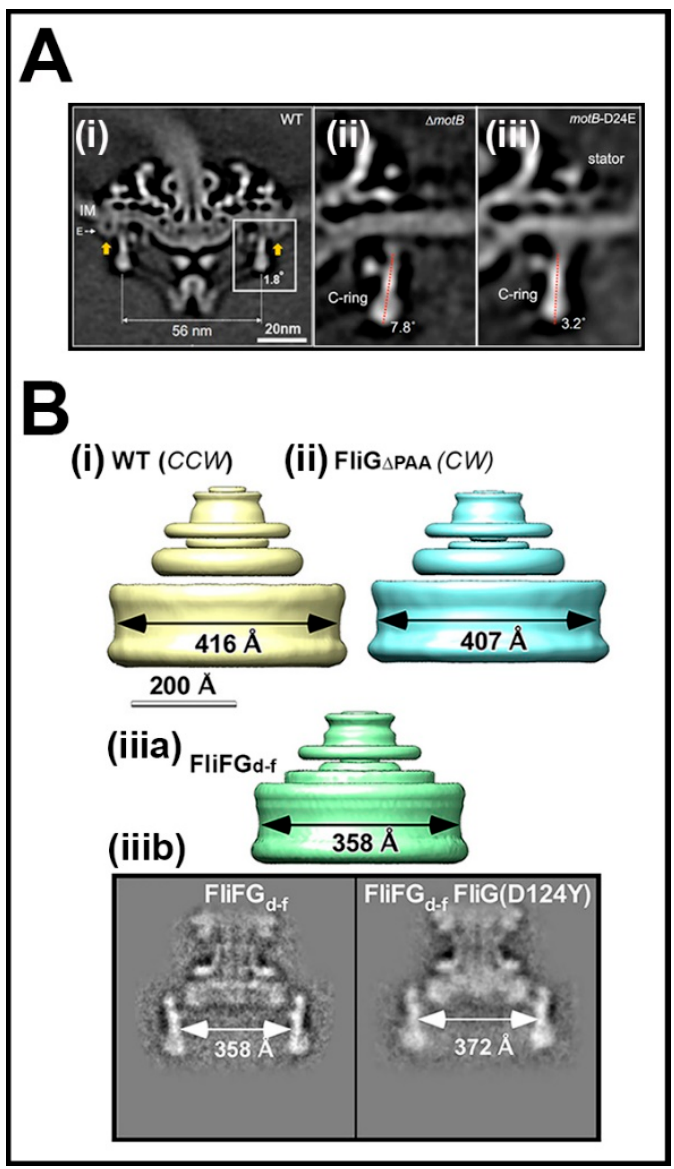
Figure 6. C ring modulation by interfacial membrane protein interactions. ( A ) C ring modulation by stator operation: ( i ) Central tomogram section of the wild-type B. burgdorferi flagellar basal structure. The C ring wall (box) is almost perpendicular (1.8°) to the Mot stator complexes (yellow arrows). The C ring has different orientations in ( ii ) ∆ MotB (7.8°) and ( iii ) MotB-24DE (3.2°) mutants. The ∆ motB strain does not assemble stators; the motB -24DE strain assembles stators and is motile (reproduced from [119] with permission). ( B ) FliF-FliG deletions alter C ring size. Size differences between S. enterica ( i ) CCW and ( ii ) CW-locked (FliG ∆ PAA ) C rings. ( iii.a ) The CW-biased S. enterica ∆ FliF–FliG fusion assembles smaller C rings. ( iii.b ) 2D class averages from the ∆ FliF–FliG fusion basal body; without and with the FliG M D124Y residue substitution that restores normal bias (reproduced from [122] with permission). internal and external modules; the cytoplasmic C ring (n = 33–36) and the external hook (n =